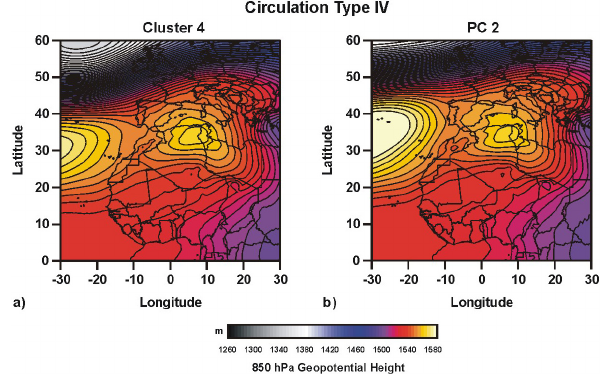
Figure 4. Composite 850hPa geopotential height (m) representing circulation type III leading to ADO over the western Mediterranean Basin.